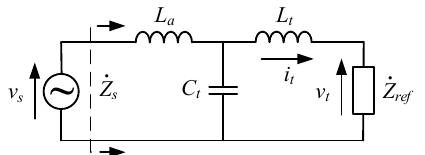
Figure 7. Circuital scheme of the track coil with inductive capacitive inductive (LCL) compensation.